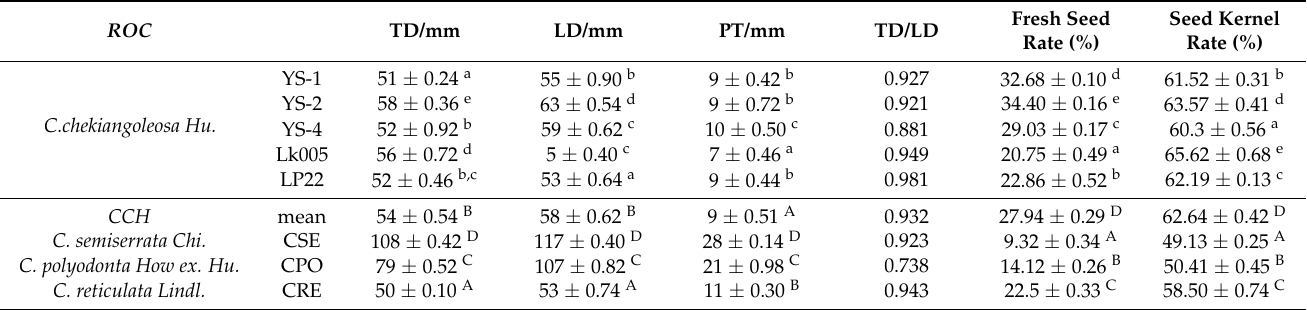
Table 1. Phenotype, fresh seed rate and kernel rate of four ROC fruits.